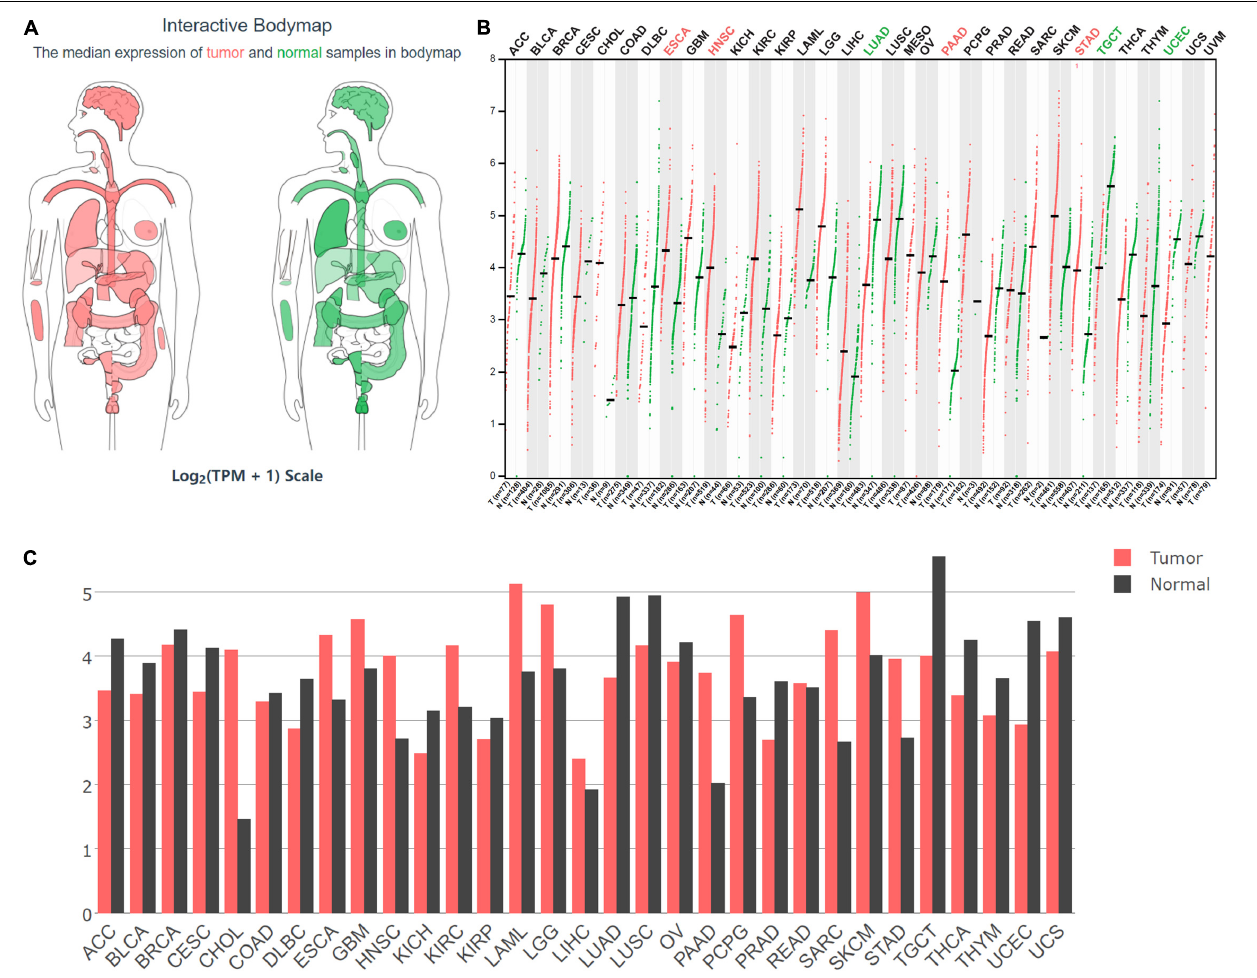
FIGURE 1 | The distribution of AMAP1 expression in various cancers. AMAP1mRNA expression distributed in a body map (A) . Dot plot of AMAP1expression profile across all tumor samples and paired normal (B) . Bar plot of AMAP1expression profile in various cancers and paired normal (C)